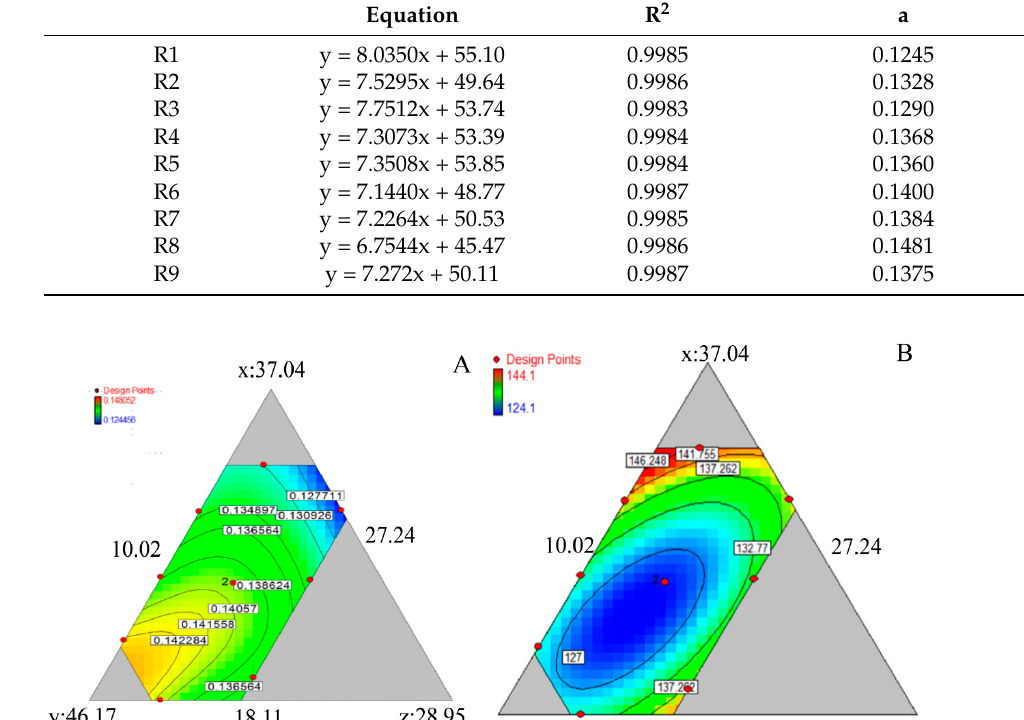
Table 2. Stress-relaxation equation in R1–R9.